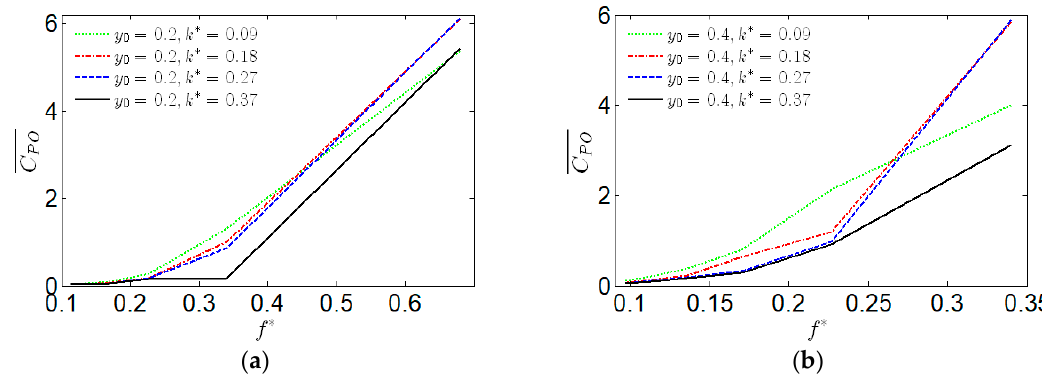
Figure 7. Comparison of the mean value of the output power coefficient for varying reduced frequencies, ( a ) y 0 = 0.2 and ( b ) y 0 = 0.4.